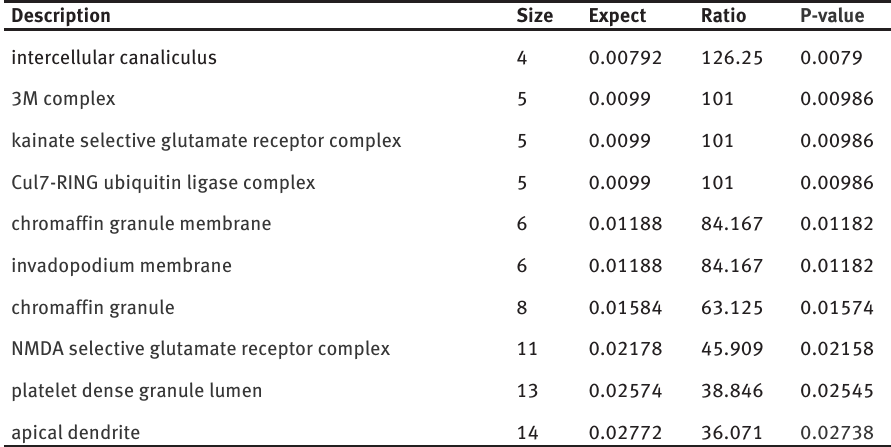
Table 2: Cellular component enrichment for iNOS/NOS2 and co-expressed genes.